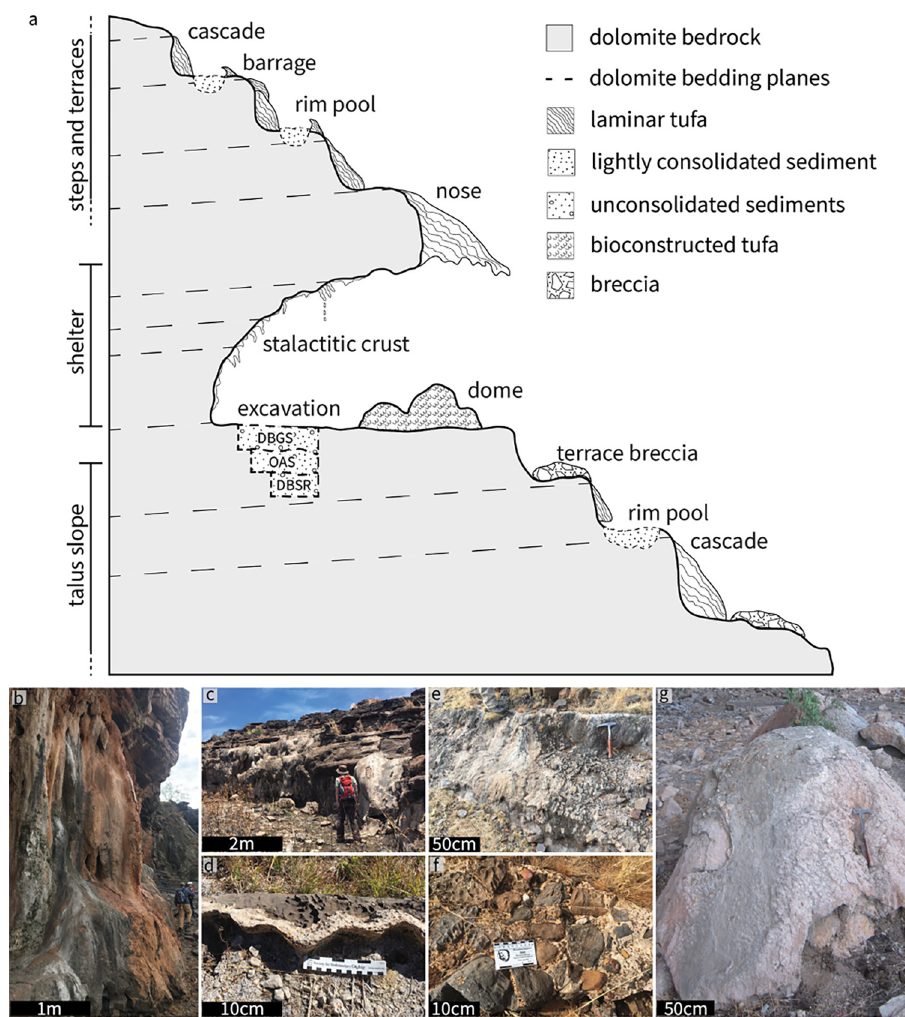
Fig 2. Tufa depositional environment context and representative photographs of each of the tufa morphologies identified on the Ga-Mohana hillside. ( A ) Schematic profile sketch of Ga-Mohana Hill North Rockshelter (not drawn to scale) illustrating the series of tufa deposits and the archaeological excavation. The excavation layers dated via OSL: DBSR = ~105 ka; OAS = ~31 ka and DBGS = ~15 ka; ( B ) cliff cascade; ( C ) step-front cascade; ( D ) sinuous rim-pool edge; ( E ) barrage tufa; ( F ) terrace breccia; ( G ) tufa dome.